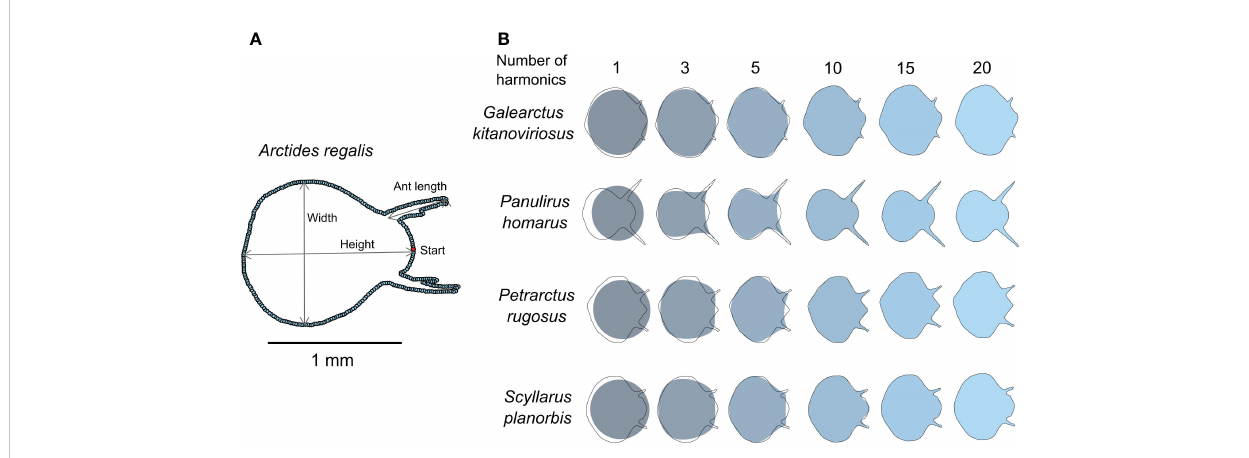
FIGURE 1 Outline processing and analysis of phyllosoma larvae I shape. (A) Shape mask labelled with the outline sampling scheme and some of the linear measurements used. Start denotes standardized starting point of outline sampling at the medium point between antennae; Ant length = antenna length. (B) Outline reconstructed from elliptic Fourier analysis. Black lines are the masks of the original outline while colour-scaled shades are the reconstructed outline shapes using different number of